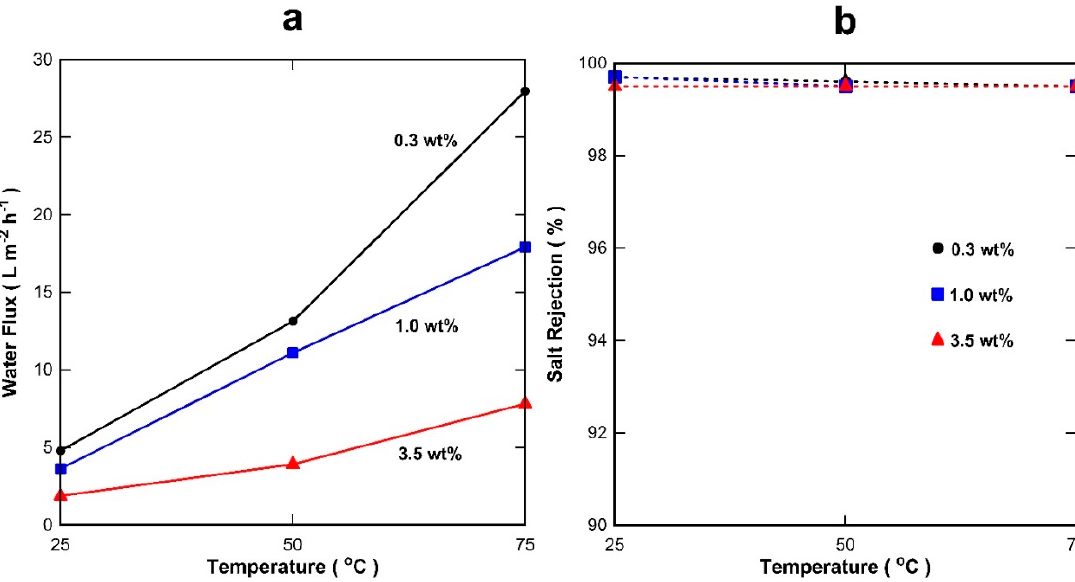
Figure 7. Desalination results for membrane S-T-1% (first coat) and -1% (second coat) ( a ) water fluxes (±8%) and ( b ) salt rejection (±1%) .